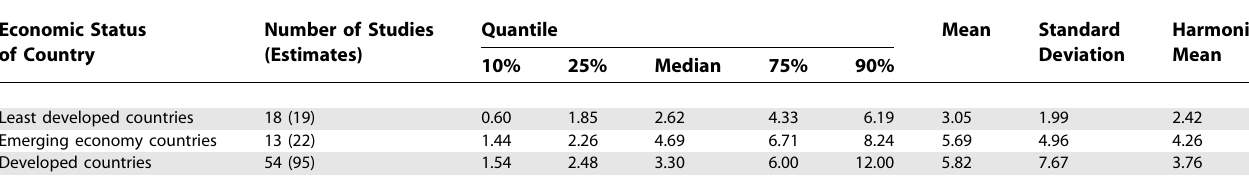
Table 11. Quantiles and Moments of Combined Prevalence Estimates per 1,000 for Persons by Economic Status of Country Economic Status of Country